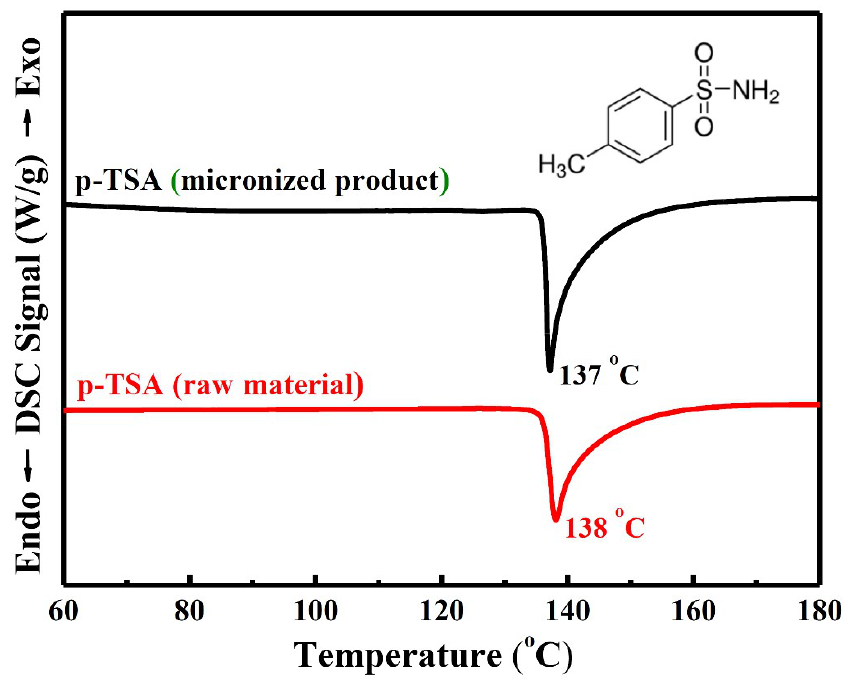
Figure 8. DSC thermograms of raw and micronized p-TSA.